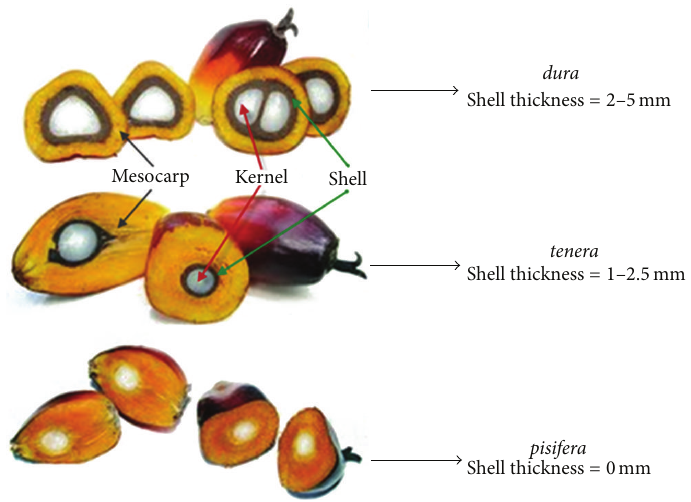
Figure 1: Species of OPS coarse aggregates.